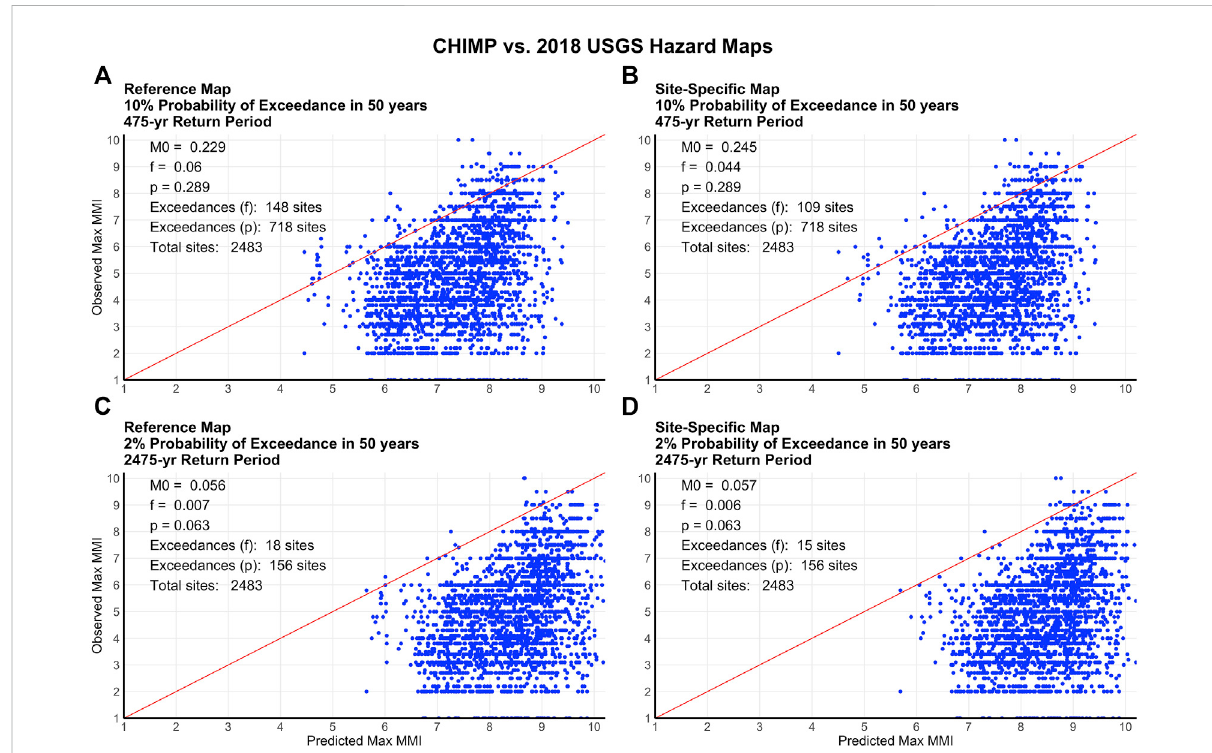
FIGURE 8 Predicted versus observed shaking for the 2018 reference USGS hazard map with a 10% probability of exceedance in 50 years (A) and a site- speci fi c hazard map (B) and for the 2018 USGS hazard map with a 2% probability of exceedance in 50 years (C) and a site-speci fi c hazard map (D) . 1: 1 line is shown in